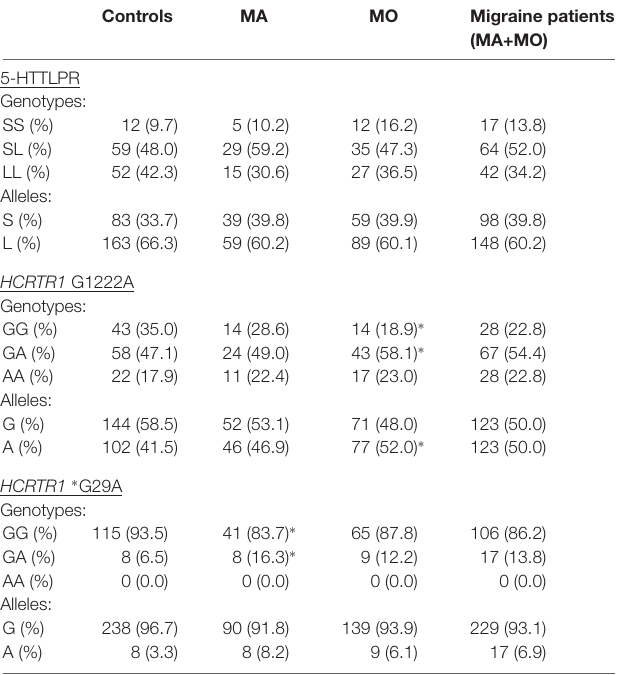
TABLE 2 | Genotype and allele frequencies of 5-HTT linked polymorphic region (5-HTTLPR) and hypocretin receptor 1 gene ( HCRTR1 ) G1222A, ∗ G29A